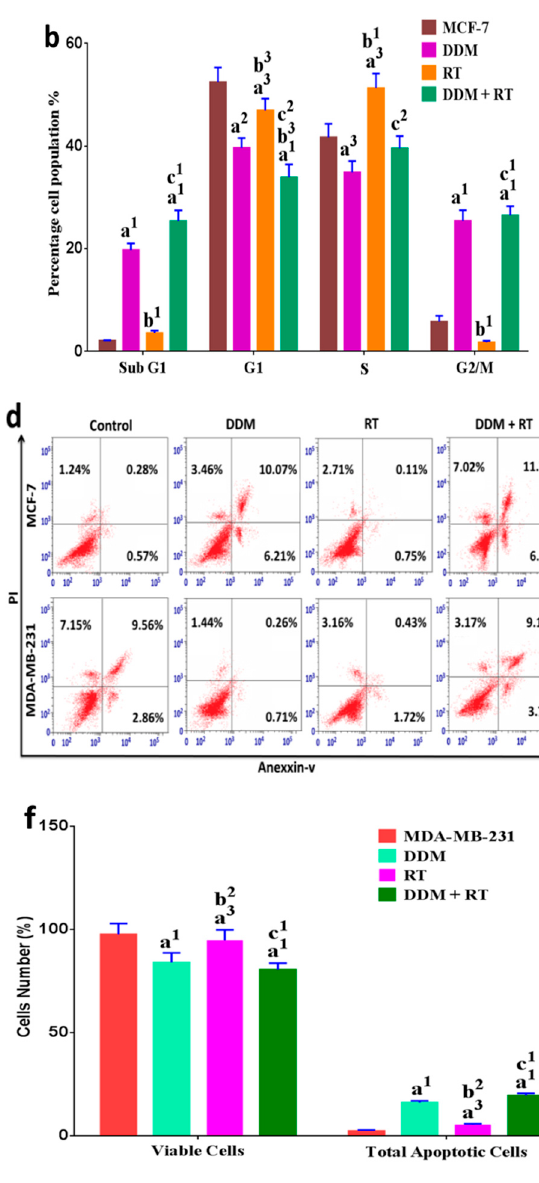
Figure 5. DDM and/or RT induced cell cycle arrest and apoptosis in BC cells. ( a – c ) Representative cell cycle images of MCF7 and MDA-MB-321 cells at G2/M arrest after a 24 h treatment with DDM or DDM + RT, and cycle arrest at S phase in MCF-7 and G1 phase in MDA-MB-231 when treated with RT only. ( d – f ) A representative dot plot of annexin-V-FITC and PI staining in BC cells treated with DDM or DDM + RT for 24 h showing increased apoptotic cells when compared with controls or RT alone. Slightly increased apoptotic cells are seen in the RT group compared to the control. Data are the mean ± standard error of the mean (SEM). a1 p < 0.001, a2 p < 0.01, a3 p < 0.05 vs. control; b1 p < 0.001, b2 p < 0.01, b3 p < 0.05 vs. DDM group; c1 p < 0.001, c2 p < 0.01, c3 p < 0.05 vs. RT group.